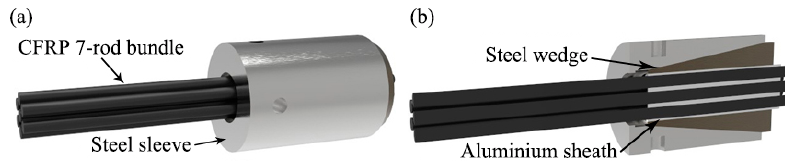
Figure 16. Modular Clamp Anchorage (one module), ( a ) full view and ( b ) sectional view.